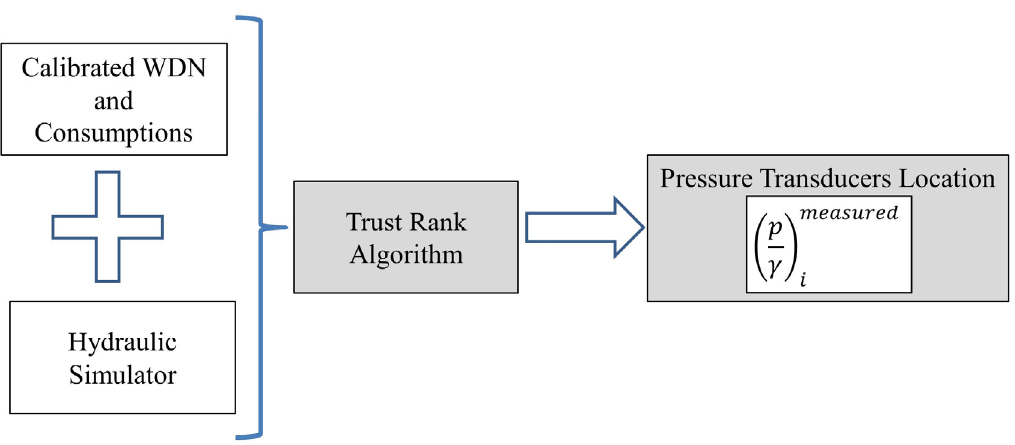
Figure 2. Methodology for selection of pressure transducers